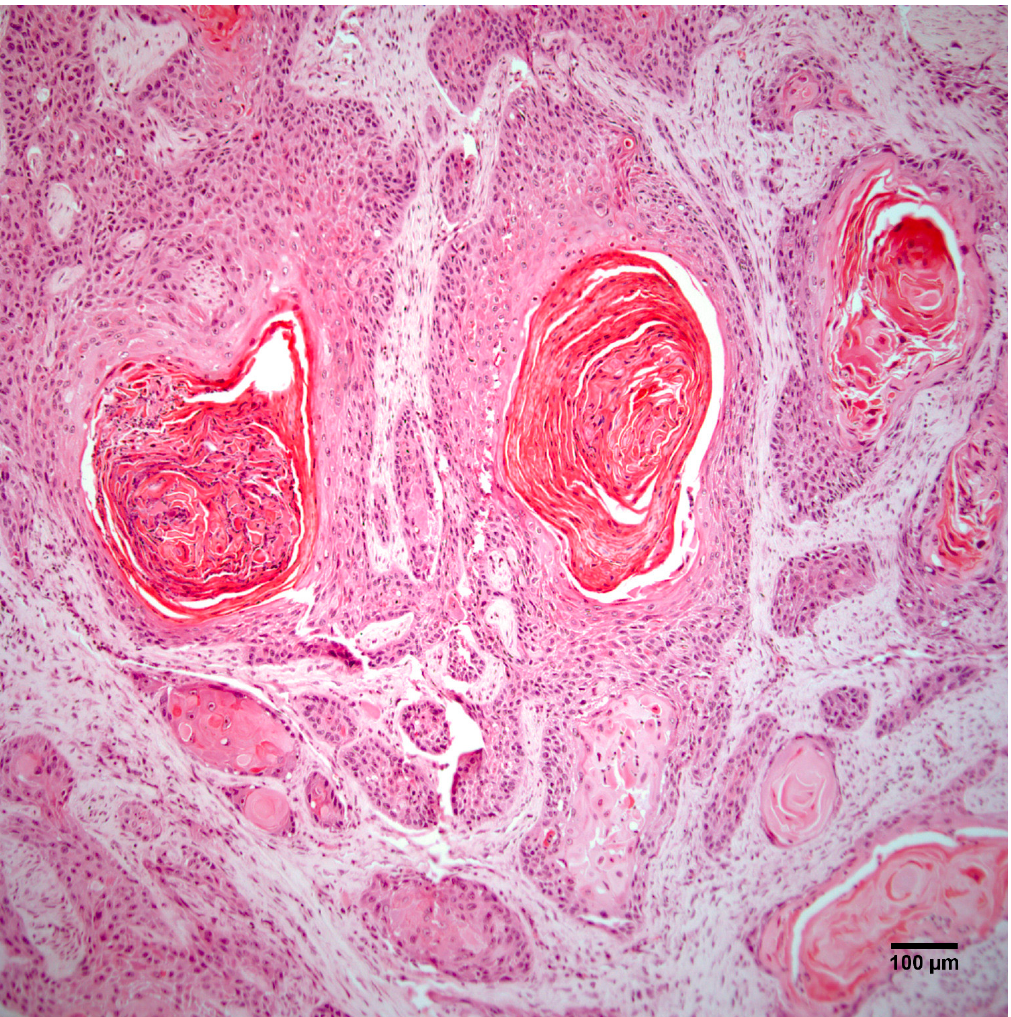
Figure 2. The right hindlimb mass is an unencapsulated dermal and subcutaneous neoplasm composed of nests, streams, and sheets of neoplastic cells that multifocally surround central accumulations of keratin. Hematoxylin and eosin staining. Scale bar 100 µm.